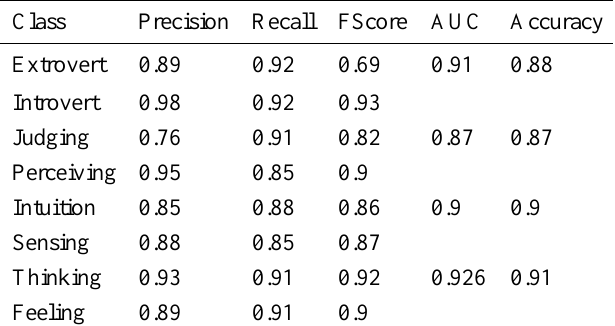
Logistic regression result with SMOTE